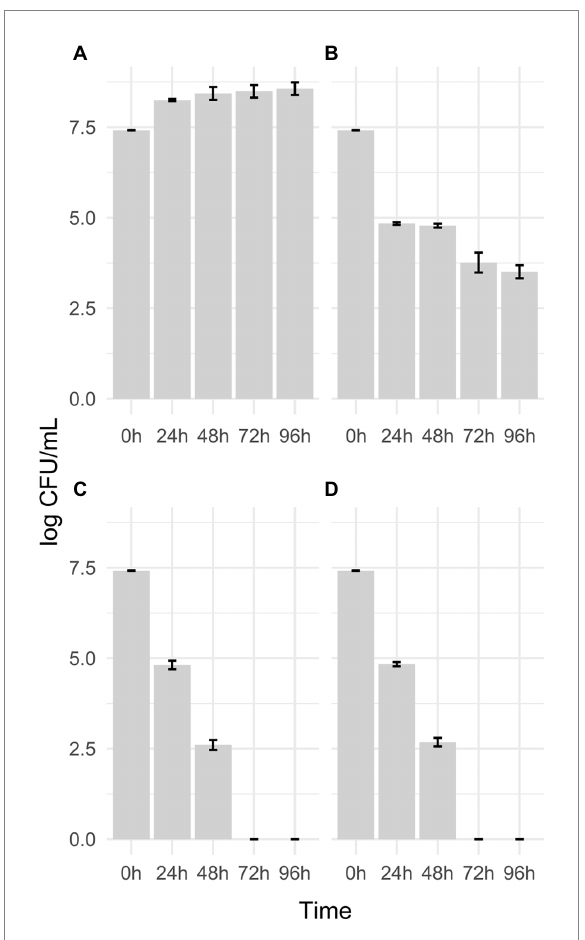
FIGURE 2 Growth performance of the presumptive G. vaginalis 5.1, 9.4, 14.2, and 17.1 clinical isolates in PMD medium supplemented with 10 μ g/ml FAC (A) ; 10 μ g/ml FAC and 32 mg/ml MTbLF (B) ; 32 mg/ml MTbLF (C) and without supplements (FAC or MTbLF; D